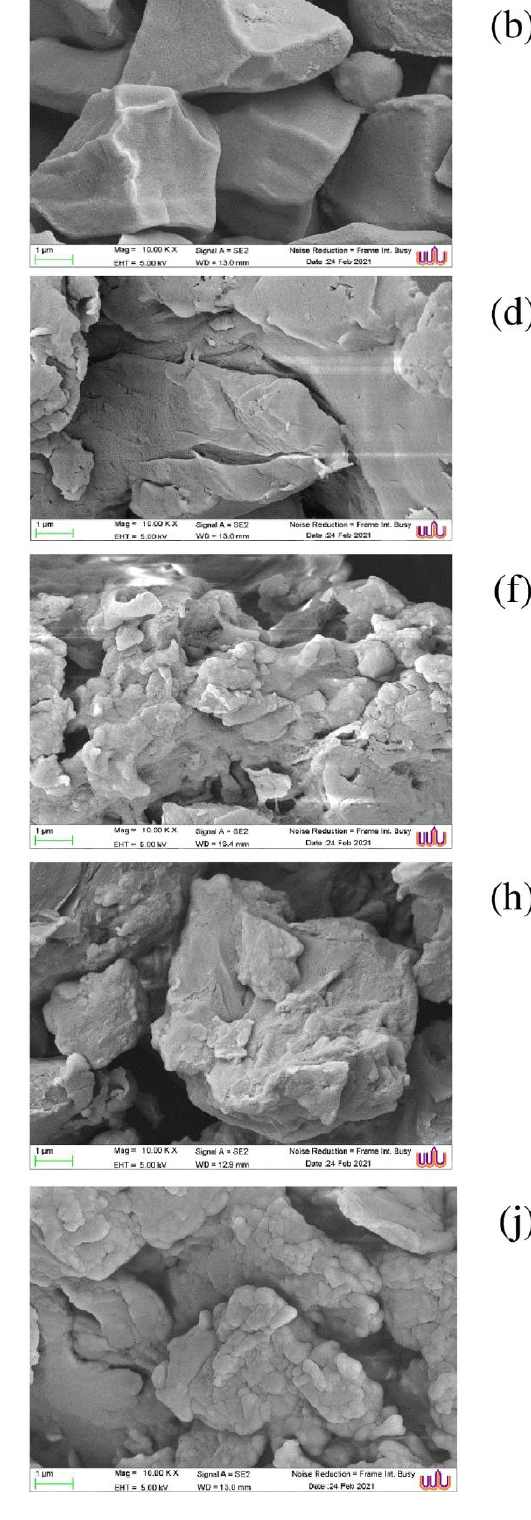
Figure 5. Scanning electron microscopic (SEM) images of native Noui Khuea (NK) starch and starch– lipid complexes with different fatty acid chain length. Native NK starch ( a , b ); starch–butyric acid complex ( c , d ); starch–lauric acid complex ( e , f ); starch–stearic acid complex ( g , h ); starch–linoleic acid complex ( i , j ). Magnification: 5000 × ( a , c , e , g , i ) and 10,000 × ( b , d , f , h , j ). EHT: 10